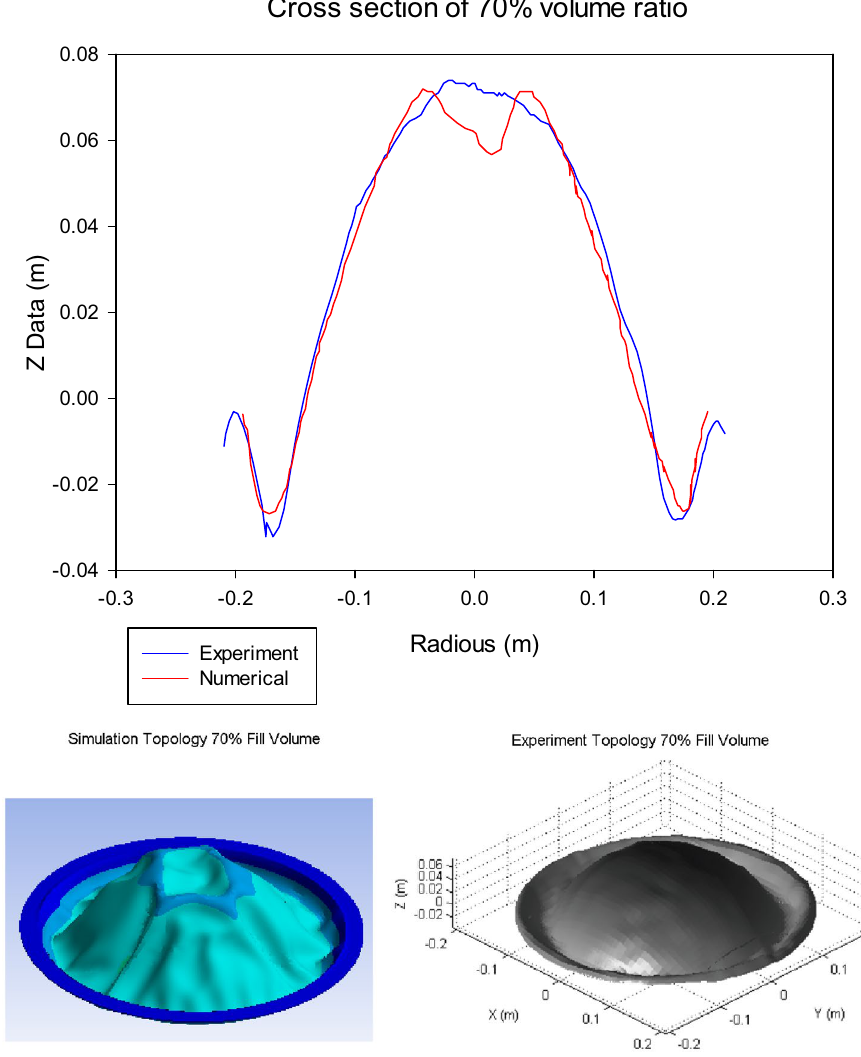
Cross section of 70% volume